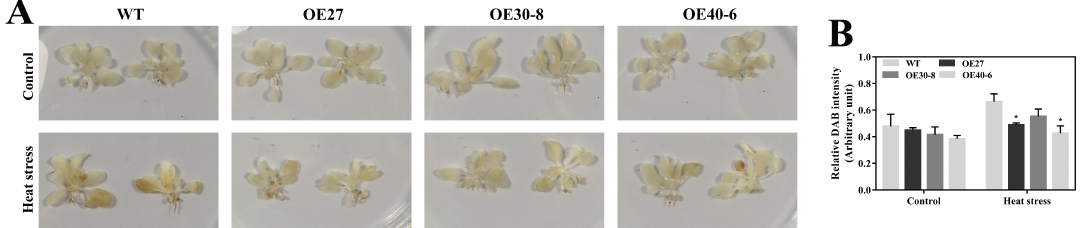
Figure 7. Detection of H 2 O 2 in the control and silenced pepper leaves. ( A ) H 2 O 2 staining from leaves of TRV2:00 and TRV2:CaHsfA1d plants post 45 °C heat treatment for 2 h. ( B ) Quantification of relative DAB staining of the control and silenced pepper. Data are means ± SD of three biological replicates. The asterisks on the top of bars indicate significant differences between the TRV2:00 and TRV2:CaHsfA1d plants. * p < 0.05 by t -test. Scale bar = 1 cm.